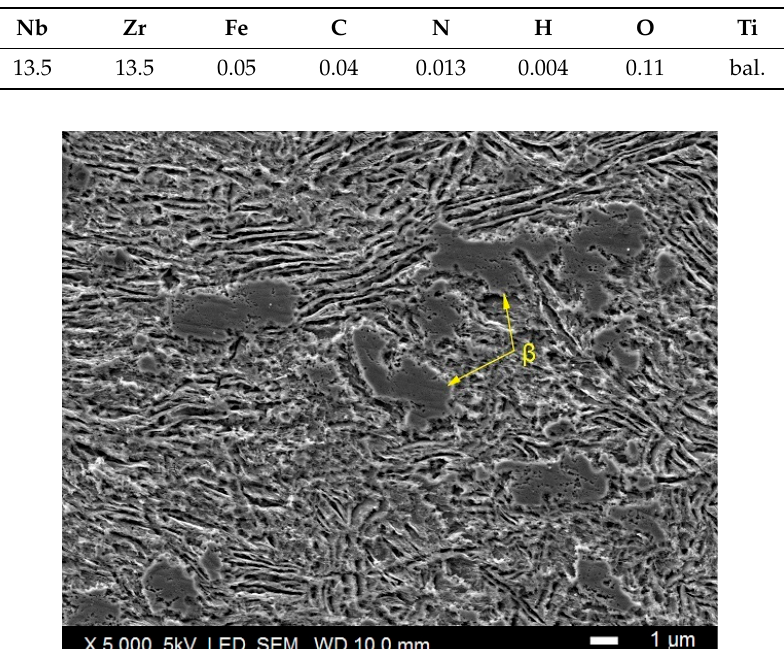
Figure 1. Microstructure of the Ti–13Nb–13Zr alloy after etching with the Kroll solution composed of 2 mL HF (40 wt.%), 2 mL HNO 3 (55 wt.%) + 96 mL H 2